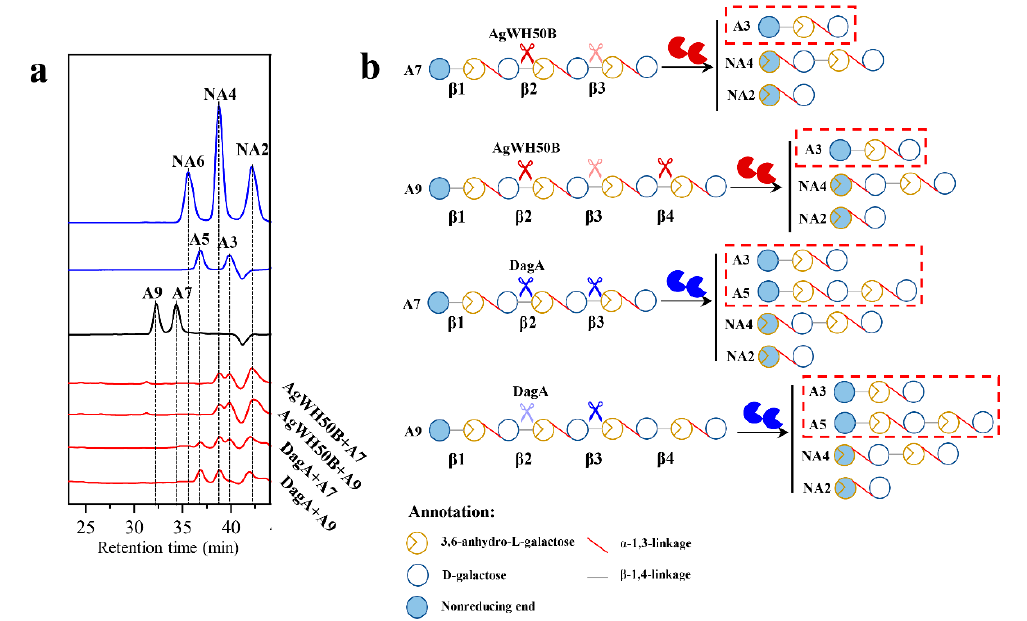
Figure 2. HPLC analysis of enzymatic production of agaroheptaose (A7) and agarononoses (A9) by AgWH50B, DagA ( a ). The cleavage sites of agarase AgWH50B ( ) and DagA ( ) act on the A7 or A9 ( b ). The shades of scissors mean the priority of the hydrolyzed AOSs.